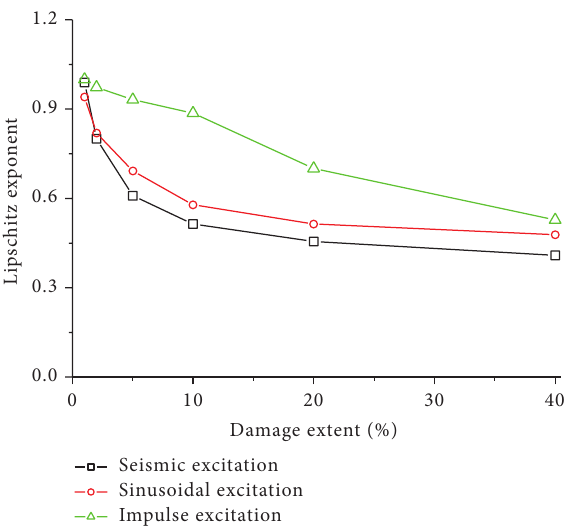
Figure 9: Decay behaviour along the modulus maximum line under seismic